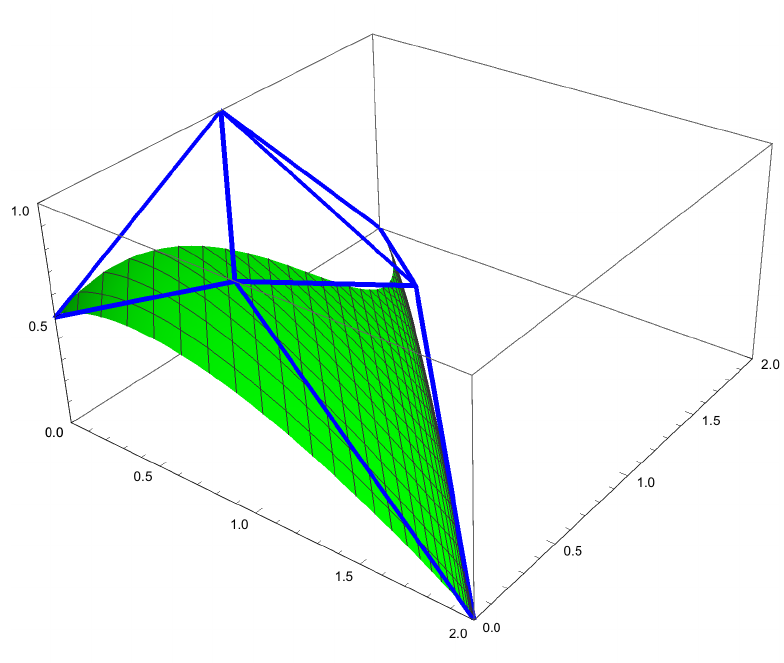
Figure 9: The graph of a redistributed triangular Meyer-König-Zeller surface, where m = 2, n = 3 and ω 2, l are the Bernstein basis functions of degree 2 with variable µ 2